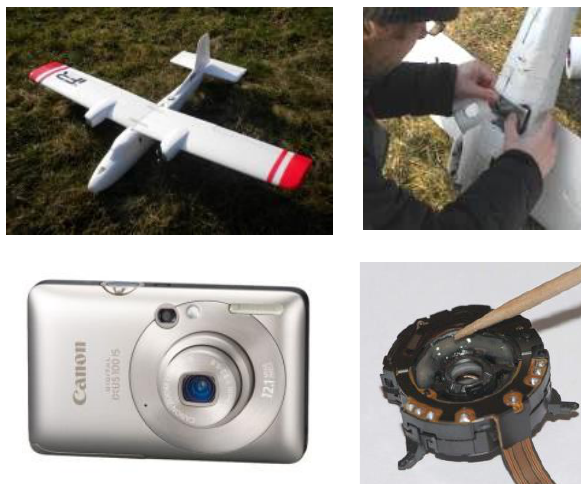
Figure 1: Platform Twinstar Multiplex (top) and Canon Ixus 100 camera with fixed lens element (bottom).